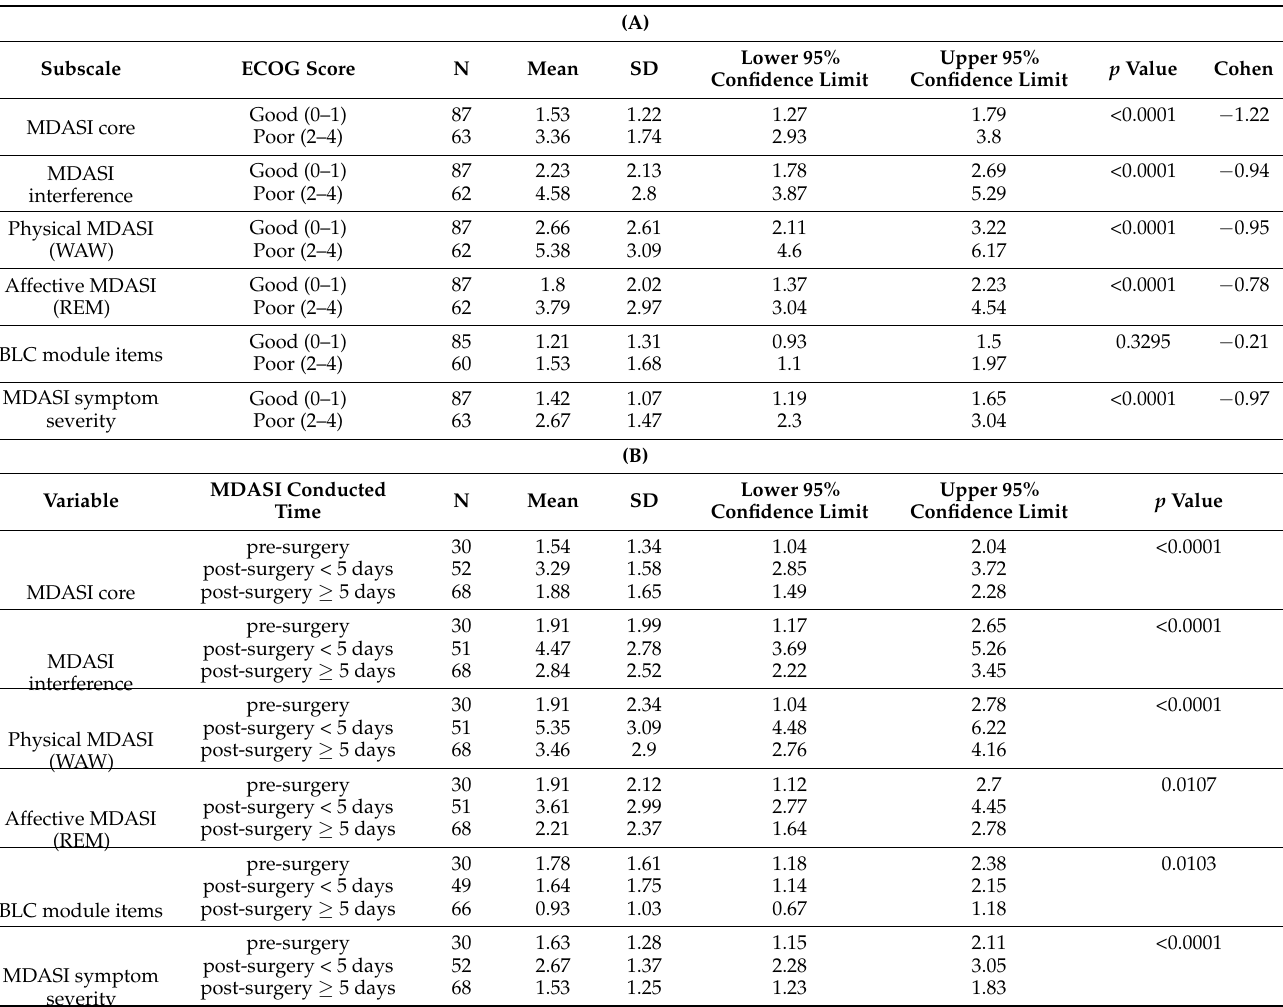
Table 3. Known-group validity of MDASI-PeriOp-BLC severity: ( A ) by performance status and ( B ) symptom severity at different time points (N =